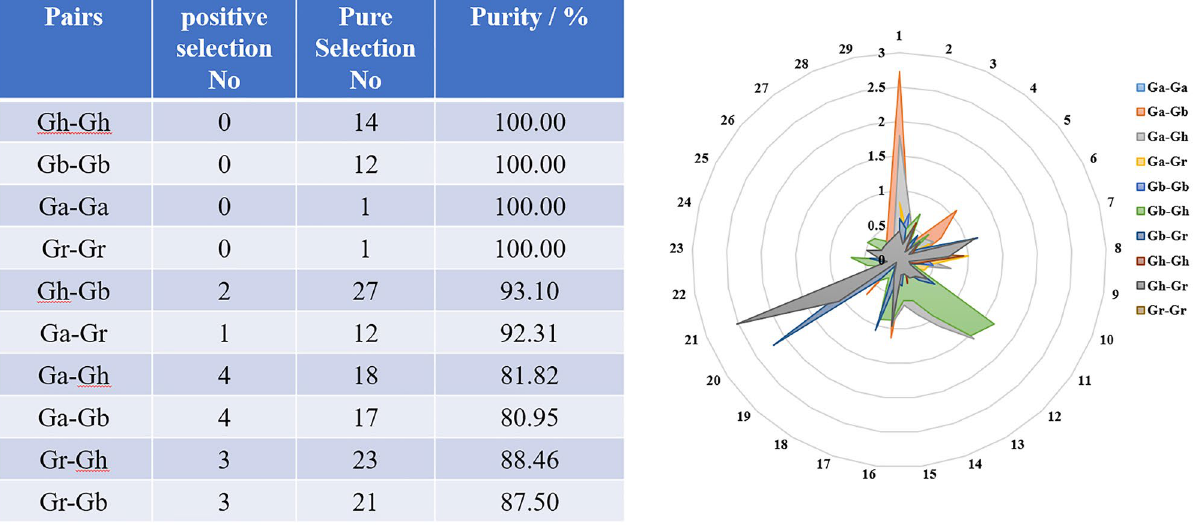
Figure 4. Ka / Ks ratio analysis of 10 combinations. Ka and Ks divergence values for (Gh-Gh), (Gb-Gb), (Ga- Ga), (Gr–Gr), (Gh-Gb), (Ga-Gr), (Ga-Gh), (Ga-Gb), (Gr-Gh) and (Gr-Gb) are shown in radar chart. Different colors represent Ka / Ks gene pairs of 10 groups.